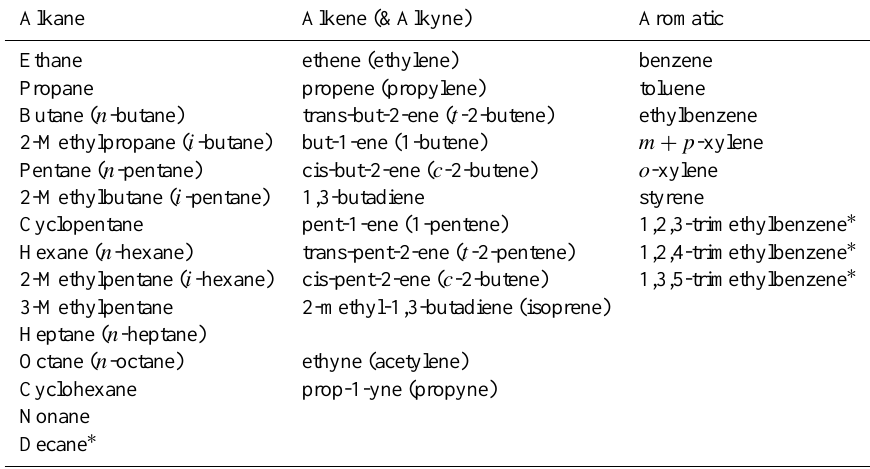
Table 1. Speciated NMHC measured with the Perkin Elmer Ozone Precursor Analyzer. Alkane Alkene (&Alkyne) Aromatic Ethane ethene (ethylene) benzene Propane propene (propylene) toluene Butane ( n -butane) trans-but-2-ene ( t -2-butene) ethylbenzene 2-Methylpropane ( i -butane) but-1-ene (1-butene) m + p -xylene Pentane ( n -pentane) cis-but-2-ene ( c -2-butene) o -xylene 2-Methylbutane ( i -pentane) 1,3-butadiene styrene Cyclopentane pent-1-ene (1-pentene) 1,2,3-trimethylbenzene ∗ Hexane ( n -hexane) trans-pent-2-ene ( t -2-pentene) 1,2,4-trimethylbenzene ∗ 2-Methylpentane ( i -hexane) cis-pent-2-ene ( c -2-butene) 1,3,5-trimethylbenzene ∗ 3-Methylpentane 2-methyl-1,3-butadiene (isoprene) Heptane ( n -heptane) Octane ( n -octane) ethyne (acetylene) Cyclohexane prop-1-yne (propyne) Nonane Decane